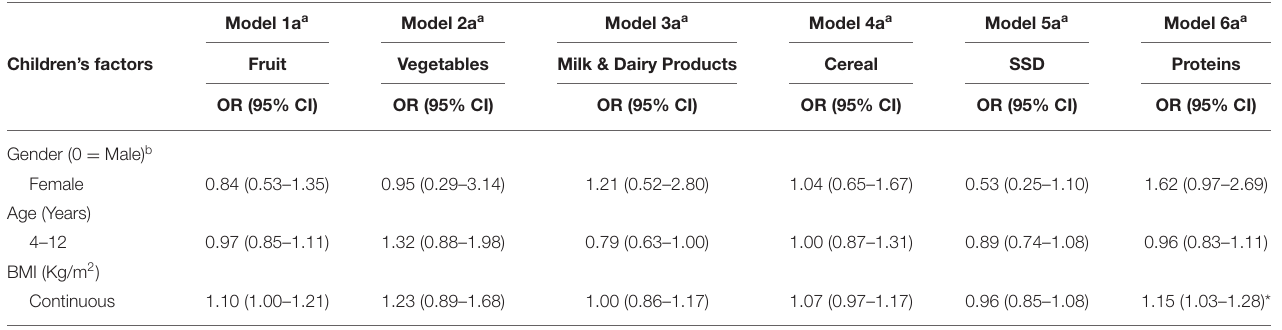
TABLE 2A | Logistic regression analyses of the associations between children-related factors and adherence of the children to the guidelines of the Swiss Society of Nutrition ( n = 287), Switzerland 2012.